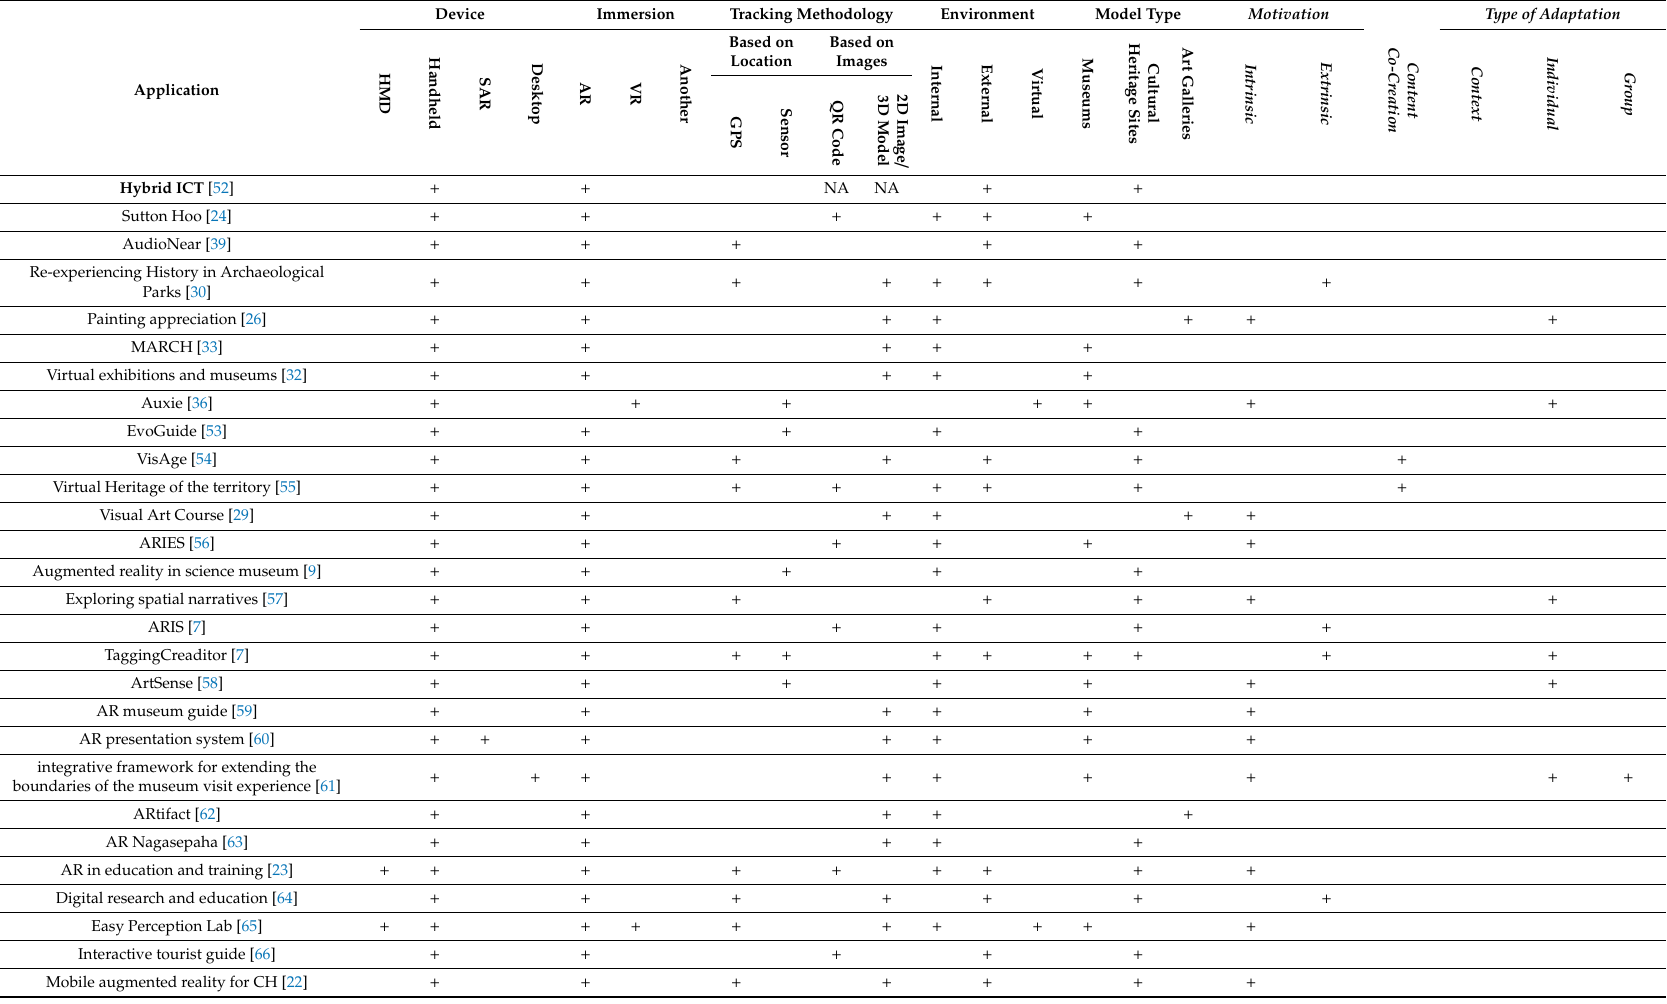
Table 1. Comparative table